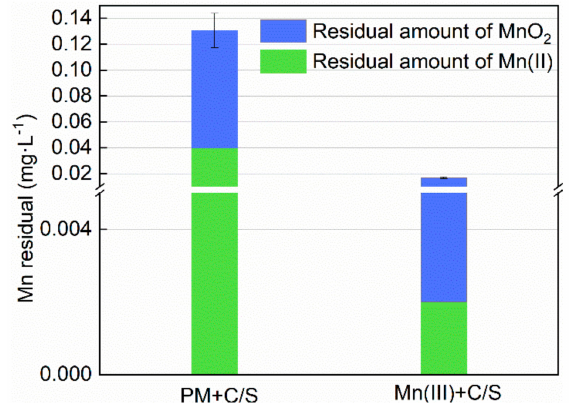
Figure 5. Mn residual in finished water of PM + C / S and Mn(III) + C /